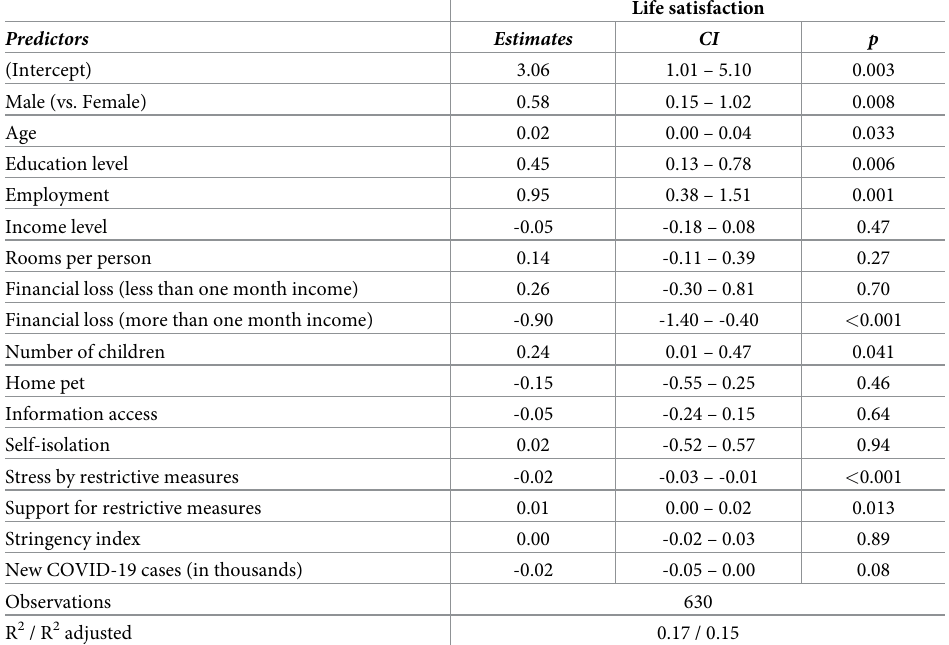
Table 3. Regression coefficients for life